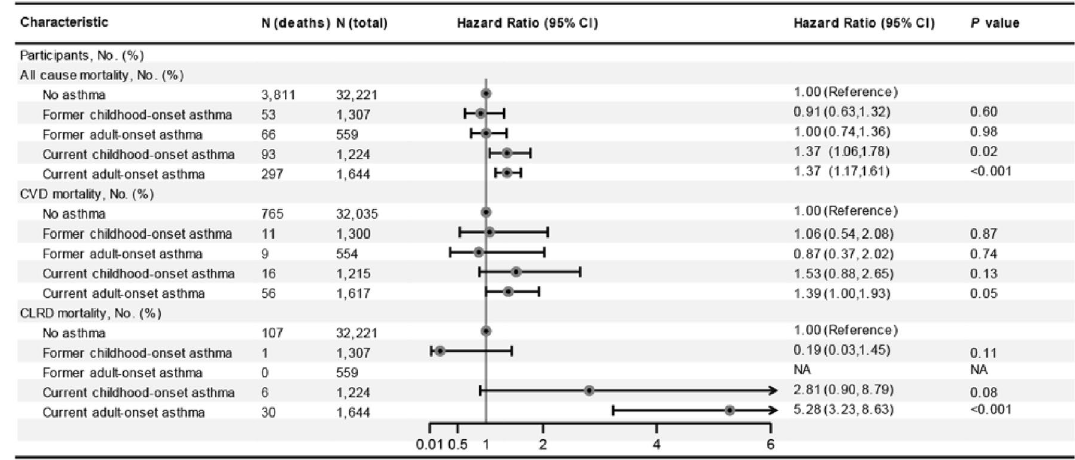
Figure 4. Risk of all-cause, CVD and CLRD mortality according to presence of asthma and its onset. CI confidence interval, CLRD, chronic lower respiratory diseases, CVD cardiovascular disease, HR hazard ratios. Multivariable models were adjusted for age, sex, race, education, income, smoking status, body mass index, diabetes, arthritis, coronary heart disease, stroke and